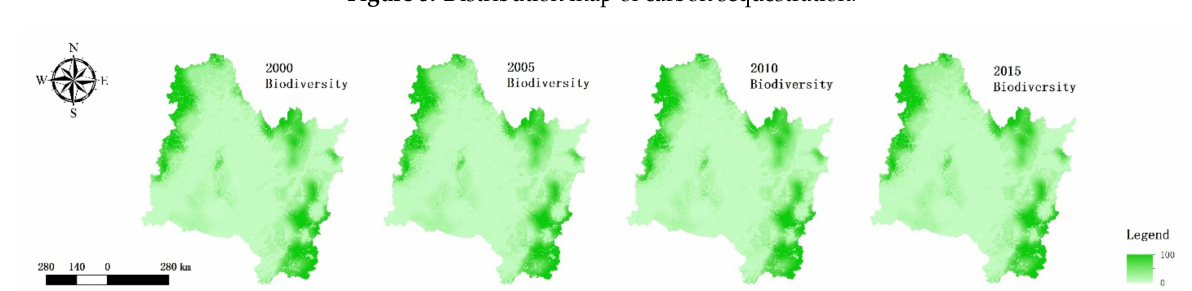
Figure 5. Distribution map of carbon sequestration.